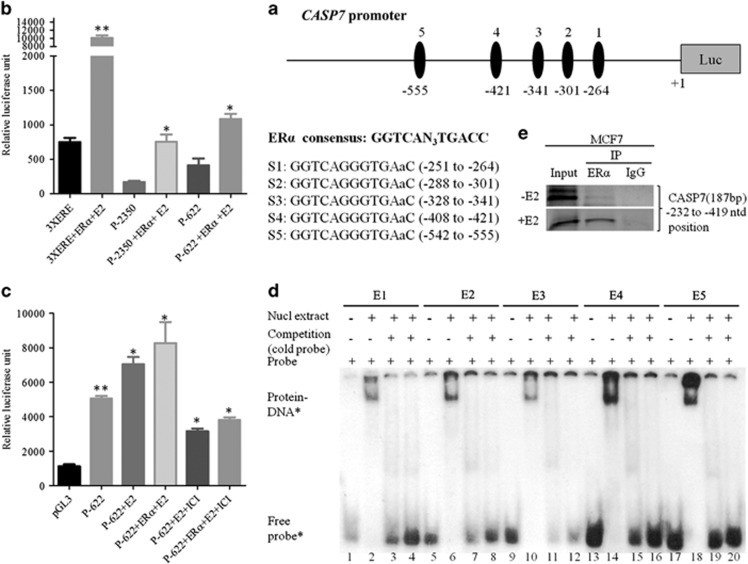
ERα classically regulates CASP7 promoter. (a) Schematic diagram of CASP7 promoter (upper panel) and putative ERα-binding sites (lower panel). (b) Relative luciferase activities after co-transfecting CASP7 promoters (P-2350 & P-622) and ERα in MCF7 cells after 48 h. The data shown are the means±s.e. of three individual experiments. (c) Relative luciferase activities of P-622 construct with ERα co-transfection after hormone and ICI treatments. The data shown are the means±s.e. of three individual experiments. (d) In vitro DNA–protein-binding assay using 30 base pair oligonucleotides containing putative ERE sites of CASP7 promoter. Cold competition reaction included 50–100-fold molar excess of consensus ERE sequence. ‘−' and ‘+' signifies with and without nuclear lysate, respectively. (e) In vivo DNA–protein-binding assay of ERα in the putative ERE sites present in the CASP7 promoter in the presence or absence of E2. **P<0.01 and *P<0.05.